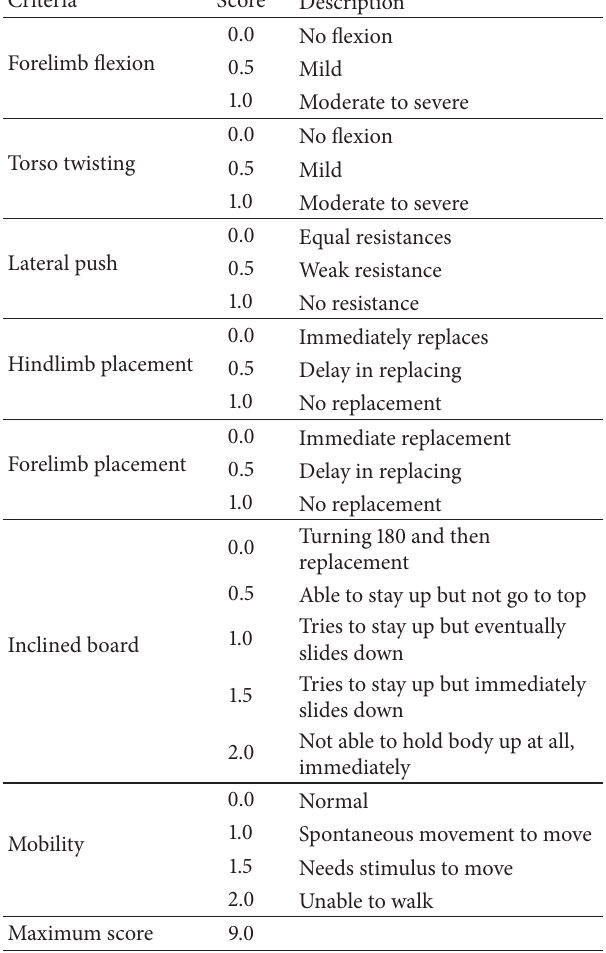
Table 1: Clinical scoring criteria (neuromuscular function).